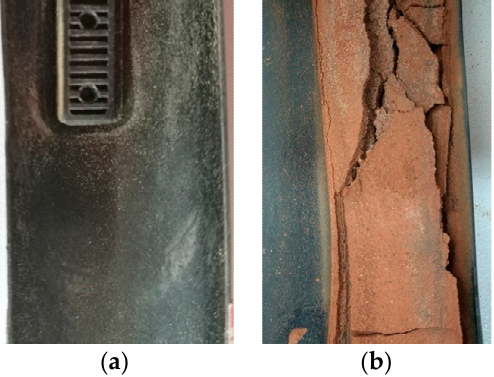
Figure 7. Residual sediments in the drip tape after tests. ( a ) Drip tape with flushing treatment; ( b ) drip tape without flushing treatment.